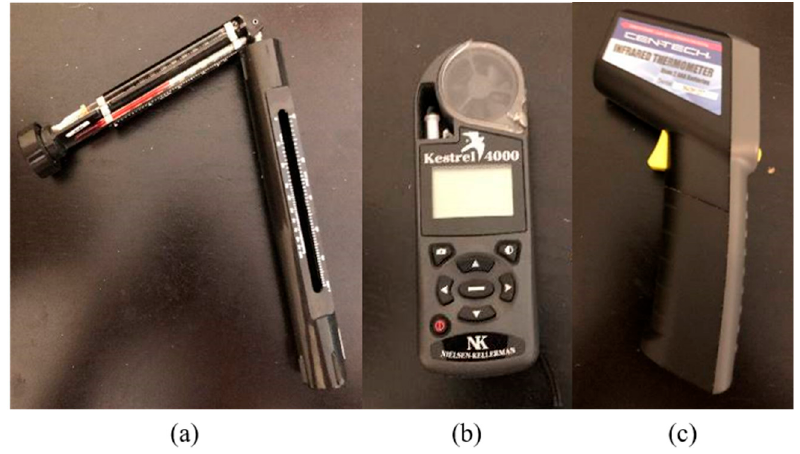
Figure 1. Images of the instrumentation used to conduct and validate the infrared psychrometry experiment: ( a ) Control: Bacharach 0012-7012 Sling Psychrometer; ( b ) Control: Kestrel 4000 Weather Meter, and ( c ) Test: Centech infrared thermometer (also known as IR Thermometer).